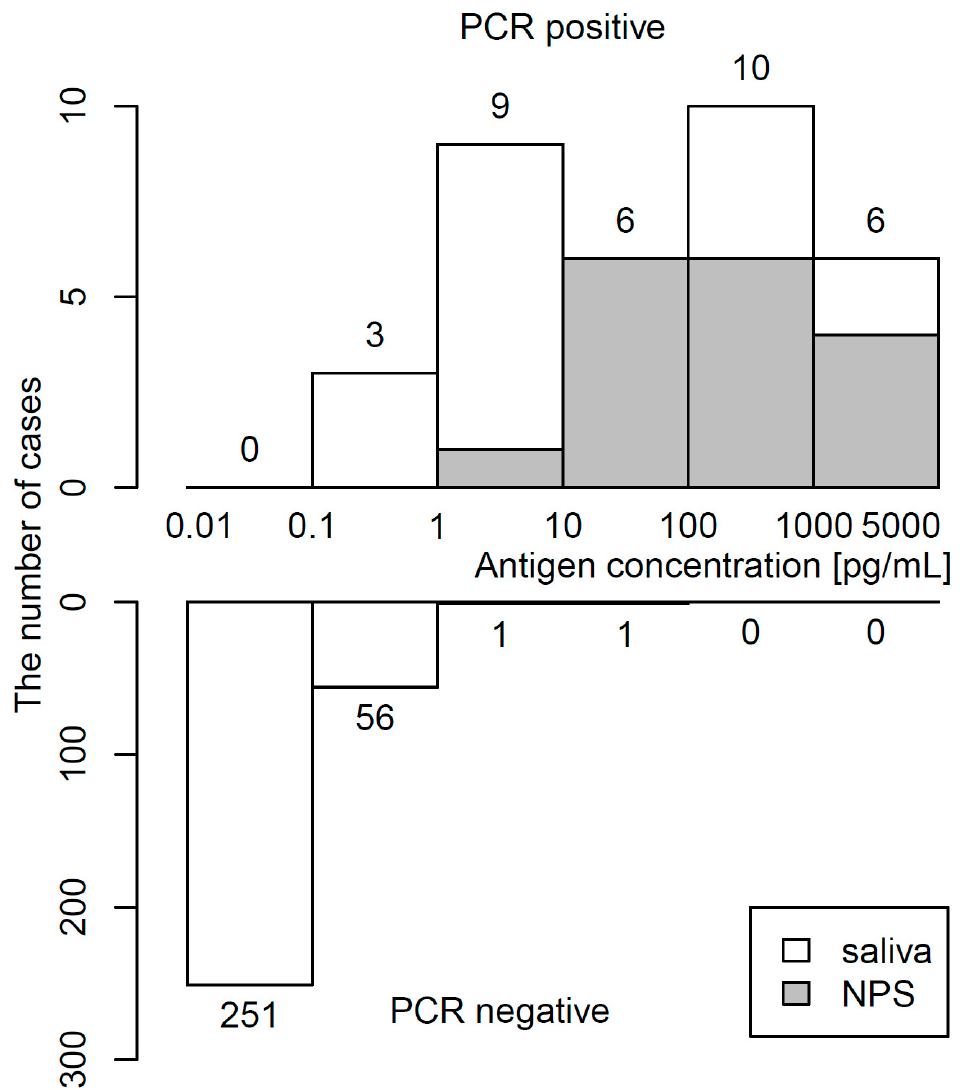
Figure 2. Histogram of antigen concentration. Upper and lower panels show frequency of PCR- positivity and PCR-negativity, respectively. Table 1. Diagnostic results in positive specimens diagnosed by RT-PCR.